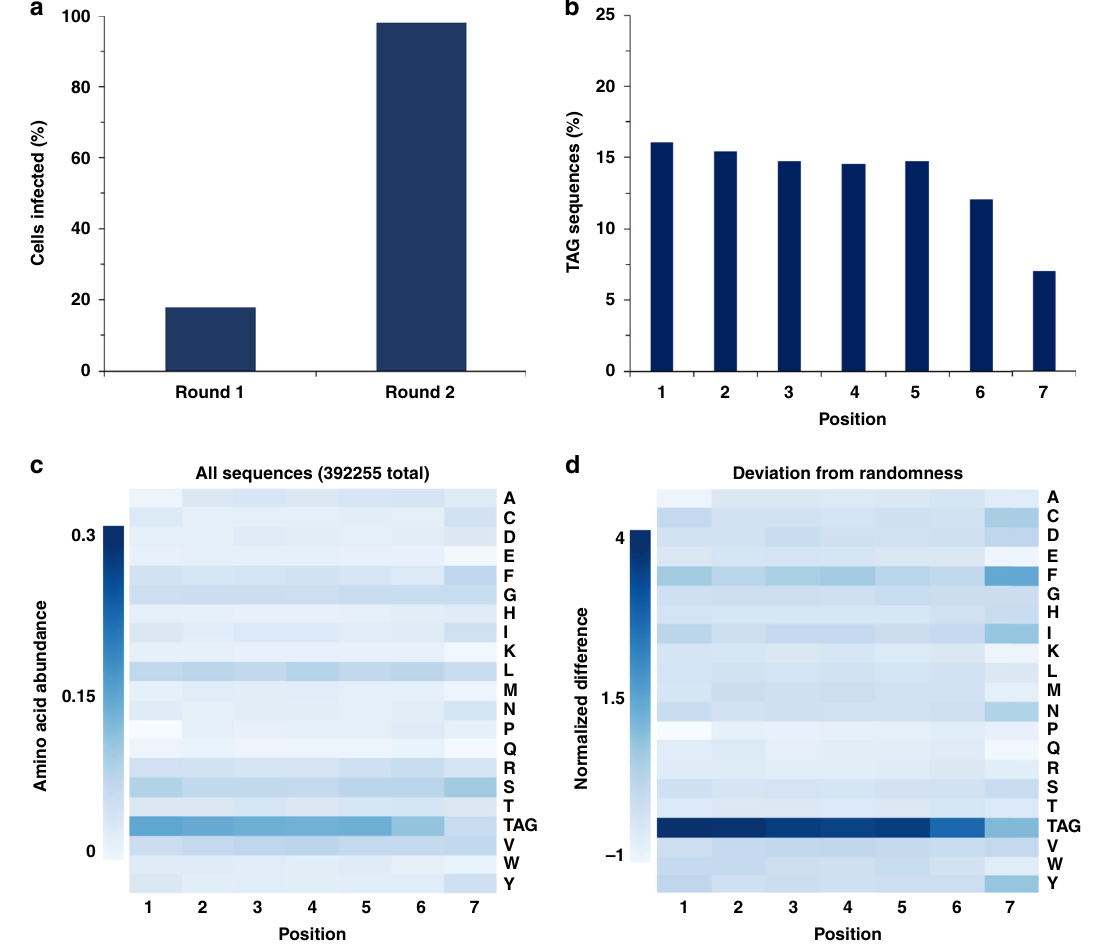
Fig. 3 Characterization of the amber-obligate phage library generated from superinfection-immunity-based selection. a During two rounds of superinfection-immunity-based selection, the percentage of the population that was susceptible to superinfection by the CM13 helper phage (e.g., clones that contained amber codons) was monitored by growth on kanamycin. The increase in the number of cells that were susceptible to superinfection between rounds 1 and 2 is indicative of the successful selection of library clones containing amber codons. b The occurrence percentages of TAG codons across the seven randomized positions in the enriched amber- obligate phage library. c A heat map showing the occurrence abundance (amount at position/total sequences) of each amino acid or the TAG codon across all library positions. d A heat map showing deviation from theoretical randomization for each amino acid or the TAG codon at all library positions. Deviation is calculated by (observed abundance-expected abundance)/expected